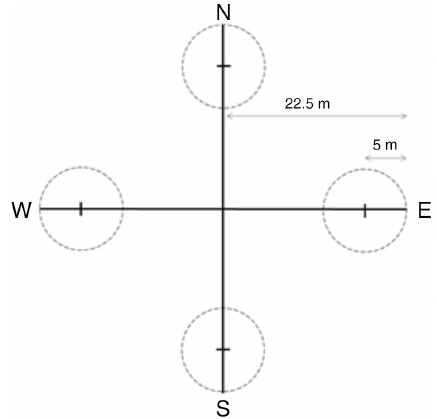
Figure 1. Plot layout for data and sample